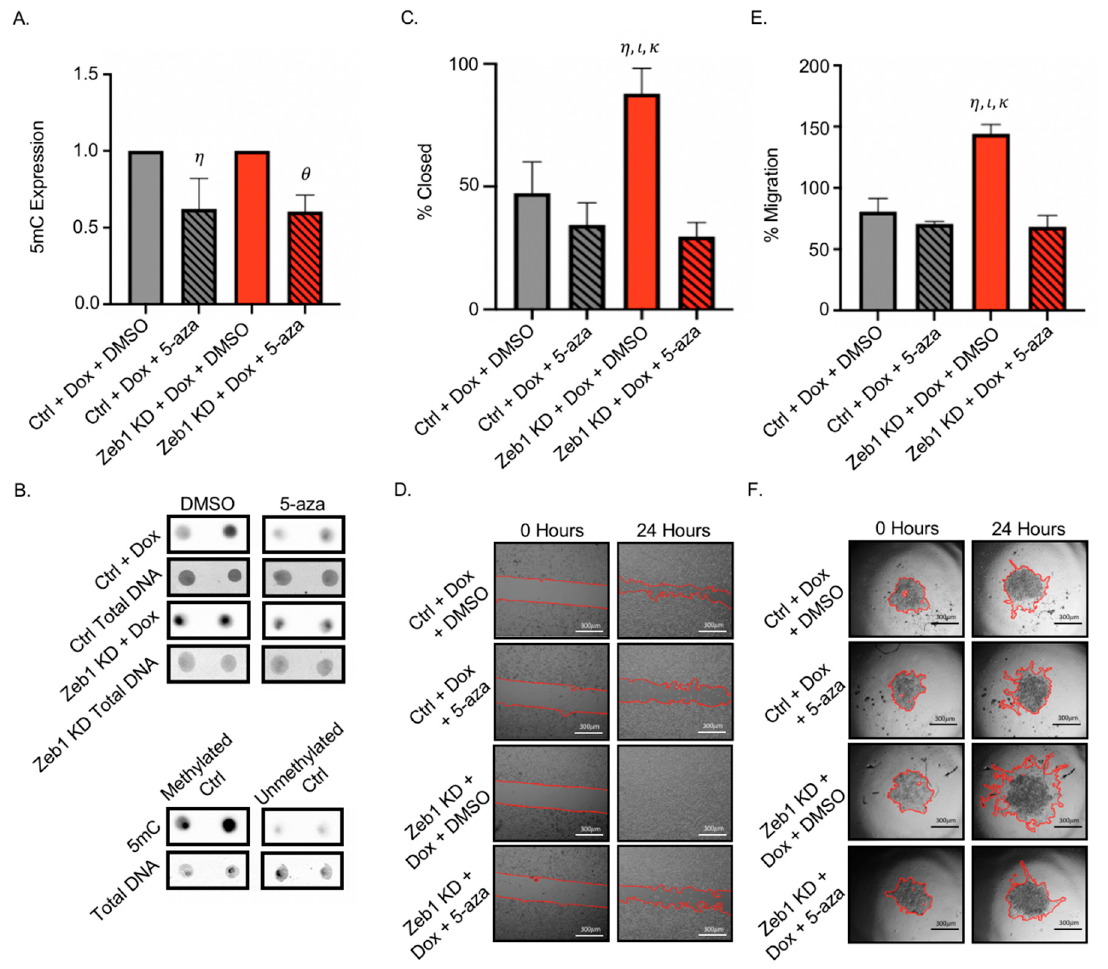
Figure 5. Treatment of PC-3 Zeb1 KD prostate cancer cells with the global demethylating agent 5-azacitadine (5-aza) results in decreased DNA methylation, migration and invasion. ( A , B ) PC-3 Zeb1 KD ( Zeb1 knockdown) with doxycycline (Dox) or control (ctrl) cells were treated with either dimethyl sulfoxide (DMSO) or 5-aza (5 µM) for 24 h and DNA was extracted to assess for global DNA methylation via dot blot assays. Representative dot blots are shown. Methylated and unmethylated DNA controls were used to validate 5-methylcytosine (5mC) expression. ( C , D ) Cells were seeded onto physical barrier cell culture dishes and grown to 90–100% confluency. Treatments (5 µM 5-aza or DMSO) were added to cells, the physical barrier was removed, and cells were allowed to migrate into the wound. ( E , F ) Cells were seeded onto ultra-low attachment plates and allowed to grow for 96 h to create spheroids. After 96 h of growth, Matrigel and 5 µM 5-aza or DMSO were added. Representative images are shown for each assay; with migration or invasion calculated based on 5 high-powered fields of view (HP-FOV) per well. Scale bars = 300 µm. Data is presented as the mean ± standard error of the mean (SEM) (n = 3). η = significantly different than ctrl with Dox and treated with DMSO. θ = significantly different than Zeb1 KD with Dox and treated with DMSO. ι = significantly different than ctrl with Dox treated with 5 µM 5-aza. κ = significantly different than Zeb1 KD with Dox treated with 5 µM 5-aza ( p ≤ 0.05).